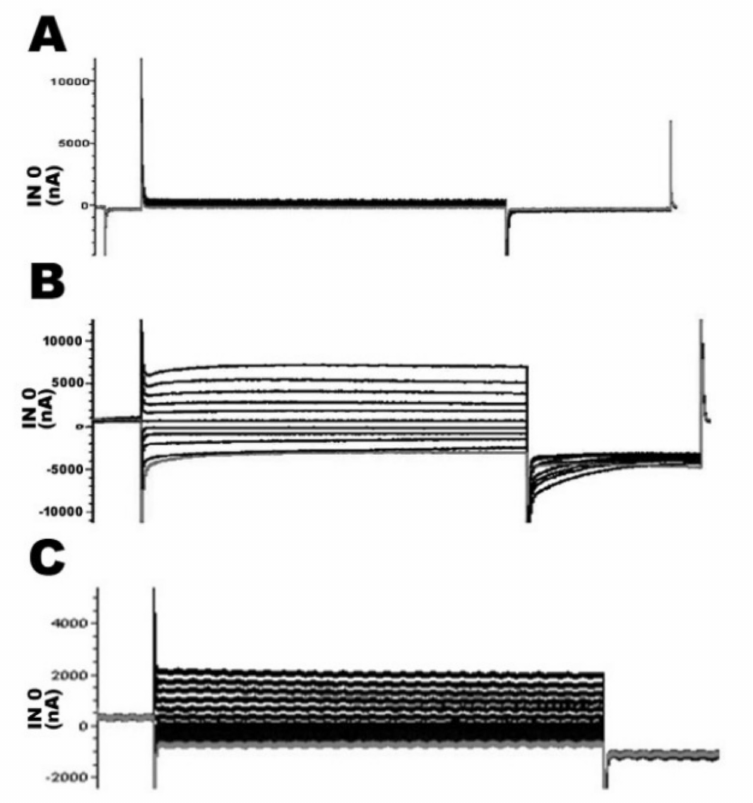
Figure 4. Assay of the Na + currents of TMPRSS3 by electrophysiological measurements in Xenopus oocytes. The amiloride-sensitive current (INa) was measured in the presence of 120 µ M of Na + in Frog Ringer with 5 µ M amiloride hydrochloride at a holding potential of 0 mV. (A) Due to the absence of any capped RNA (cRNA) as a negative control, the Na + current was not produced and measured. (B) Co-injected cRNA of TMPRSS3WT and rat epithelial sodium channel (ENaC) α , β , and γ subunit into Xenopus oocytes, resulting in increased Na + currents up to 5000–6000 nA (C) In contrast, the Na + current was decreased to about 2000 nA in the amiloride hydrochloride